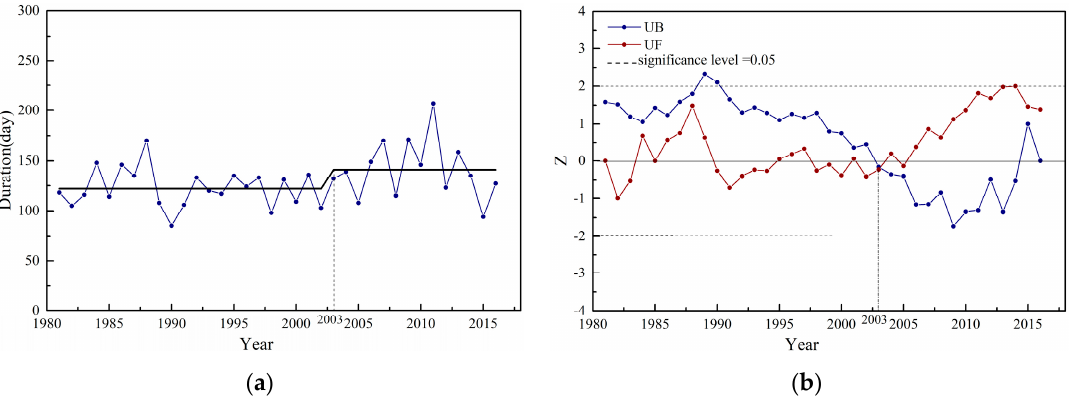
Figure 7. The long-term change of the duration of the dry period. ( a ) The duration of the dry period from 1981 to 2016; ( b ) the M-K test of the duration .